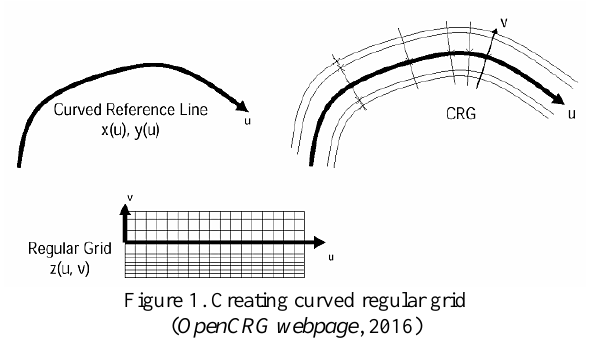
Figure 1. Creating curved regular grid